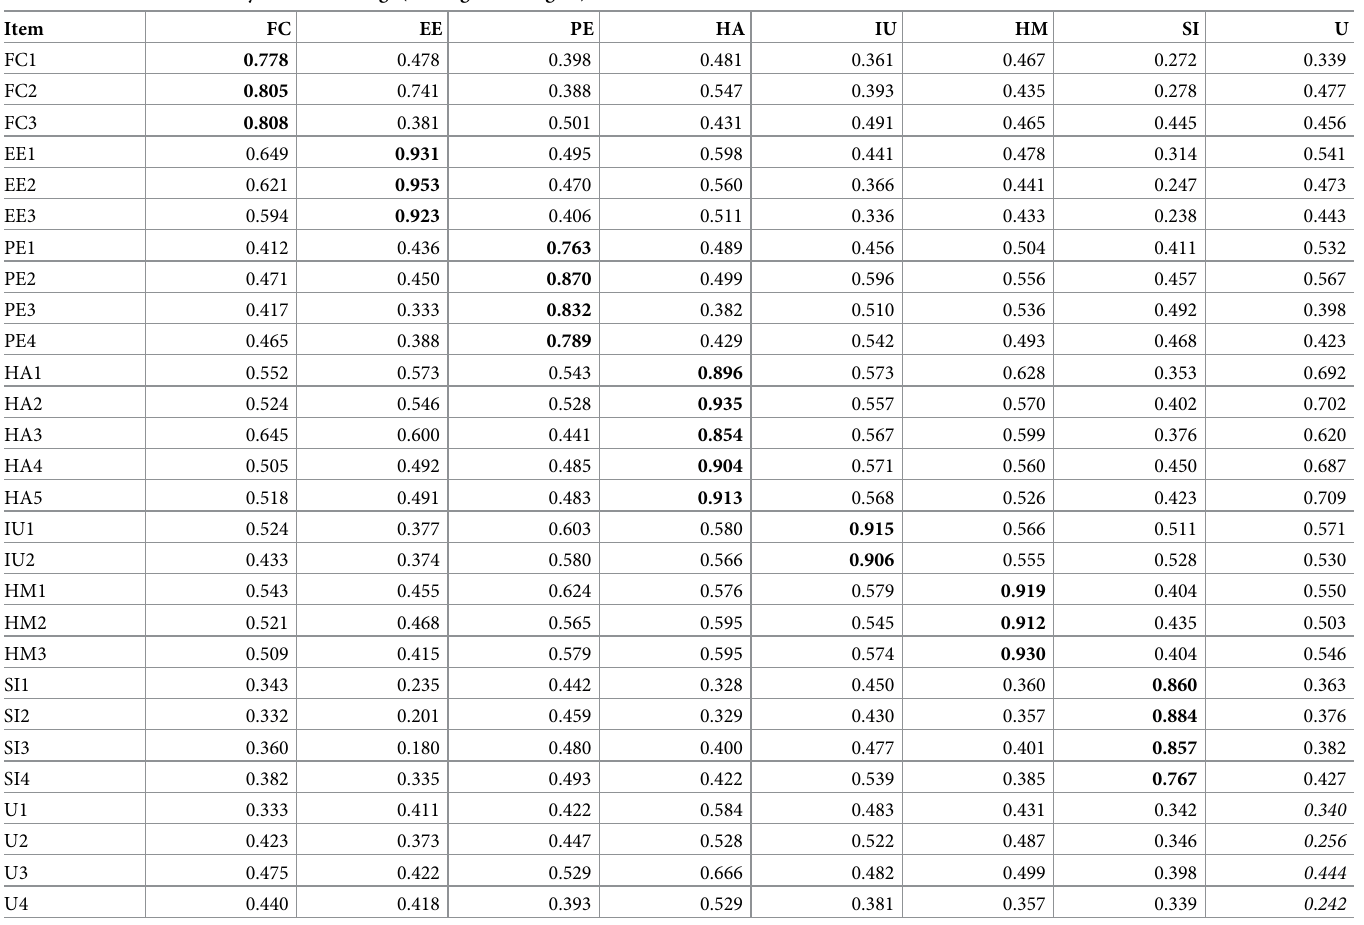
Table 3. Discriminant validity—Cross loadings (loadings and